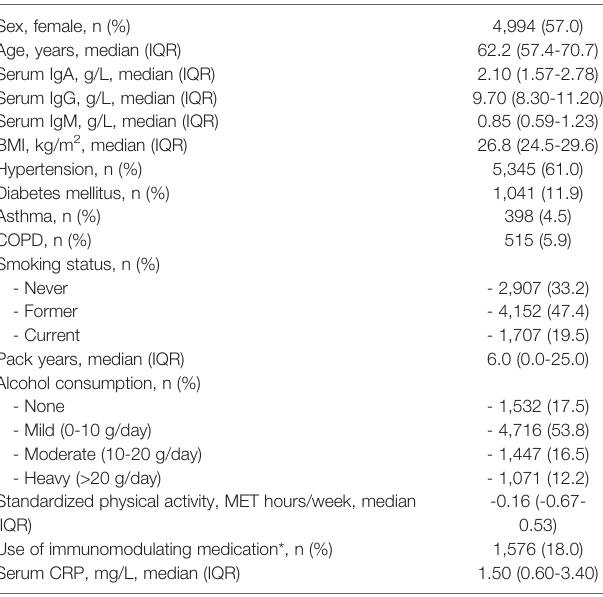
TABLE 1 | Baseline characteristics of 8,766 participants with immunoglobulin measurements and informed consent for